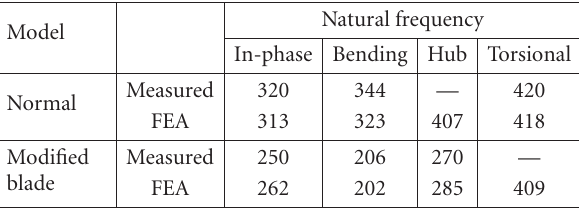
Table 6: Comparison of natural frequencies for normal fan with those for modified-blade fan